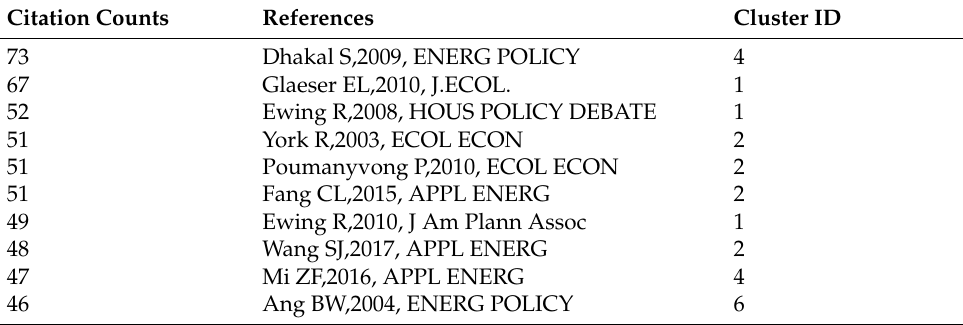
Table 3. The top 10 co-citation frequencies of the